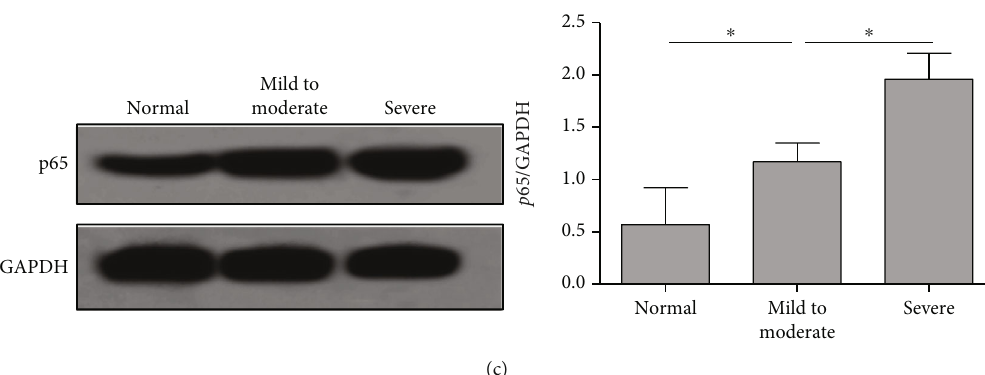
Figure 5: The expression of autophagy markers and p65 in colonic tissues of CD patients. (a) The percentage of ATG16L1, LC3, and p65 in colonic mucosa of normal controls or CD patients was detected using IHC staining ( × 100). (b) The expression of ATG16L1, LC3, and LC3II in colon tissues of normal controls or CD patients was detected using western blot. (c) The expression of p65 in colon tissues of normal controls or CD patients was examined by western blot. ∗ P < 0 : 05